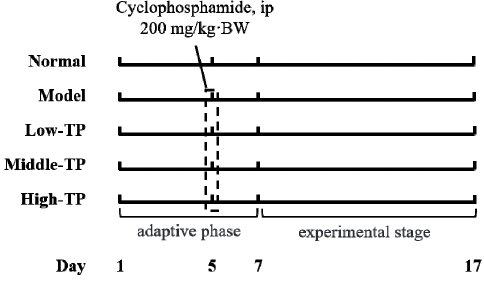
Figure 1. Experimental process in this study.